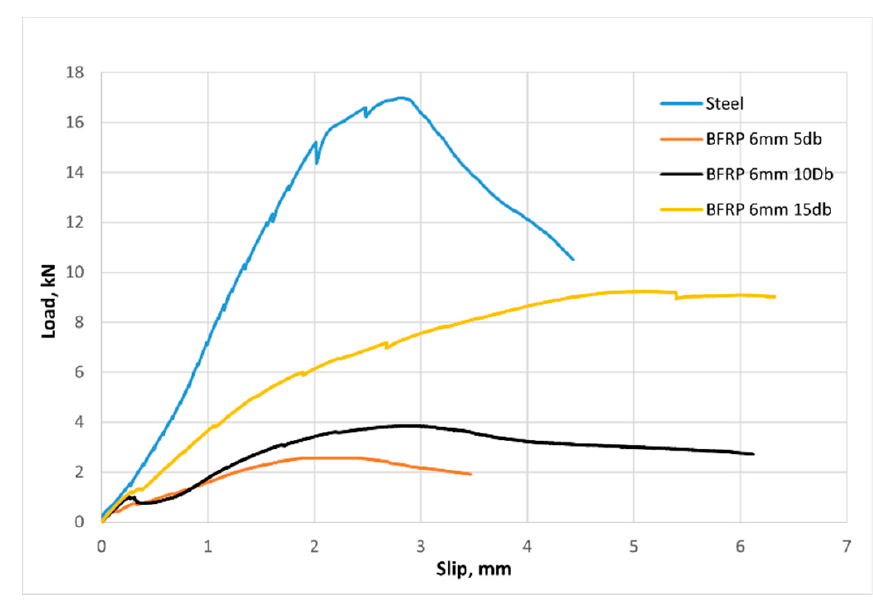
Figure 21. Load–slip relationship of the 6-mm BFRP and steel bars. Moreover, the load–slip relationship comparing the performance of 10-mm BFRP bars of various embedment lengths (5 d b , 10 d b , and 15 d b ) against the performance of steel bars is also plotted below in Figure 22.